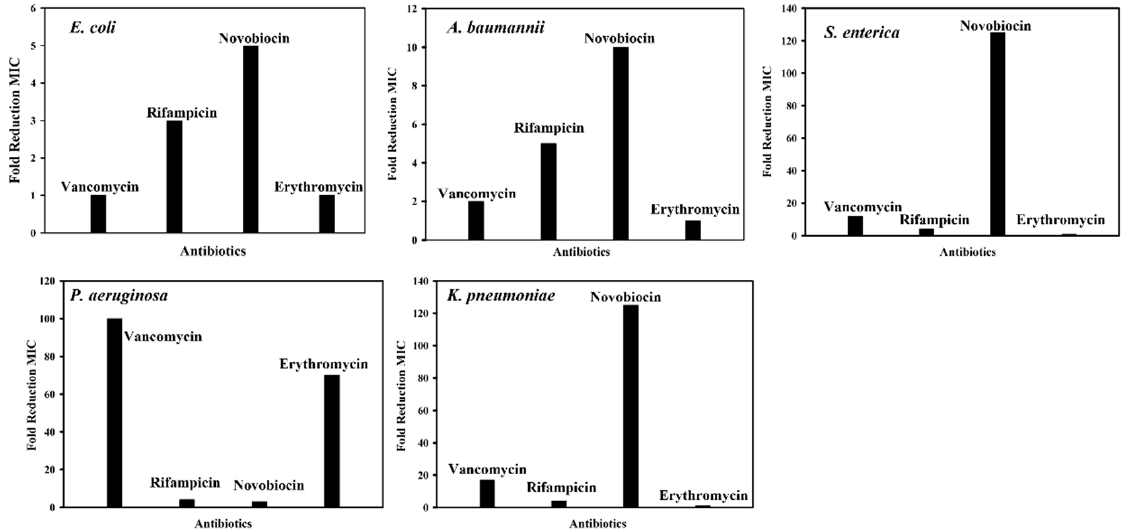
Figure 9. Bar diagrams showing fold reduction in MICs of antibiotics of grown inhibition of Gram- negative bacteria in the presence of 16 μ M cWY6 peptide.